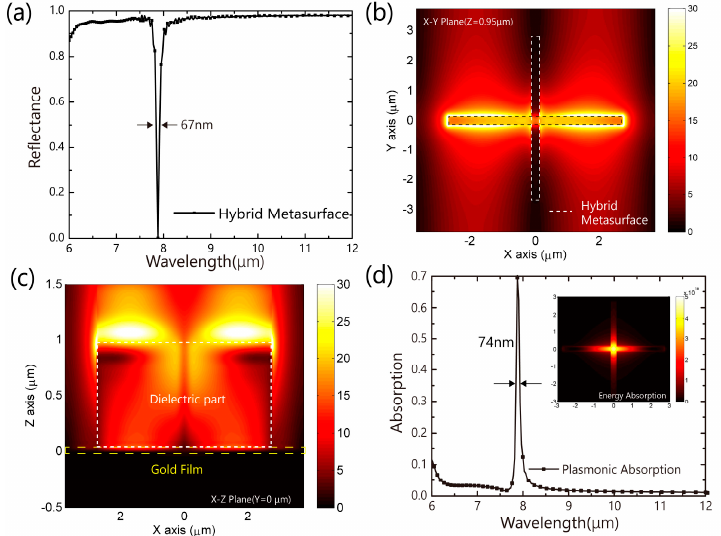
Figure 3. ( a ) The reflectance spectrum of the dielectric metasurface (cross bar with gold film. The FWHM is 67 nm; the E-field distribution of the metasurface at x - y plane ( z = 0.95 µ m) and x - z plane ( y = 0 µ m) at 7.88 µ m is shown in panel ( b ) and ( c ), respectively. There is a strong E-field localization at the edges of the horizontal bar; ( d ) the power absorption spectrum( d ) of the total structure calculated by the finite di ff erence time domain (FDTD) method. The insets are the absorption distribution at x - y plane ( z = − 16 nm inside the gold film).